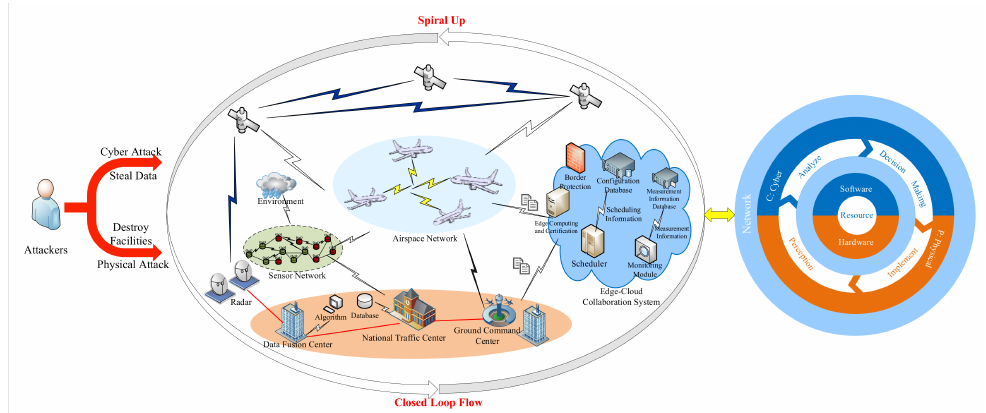
Figure 3. ATMCPS